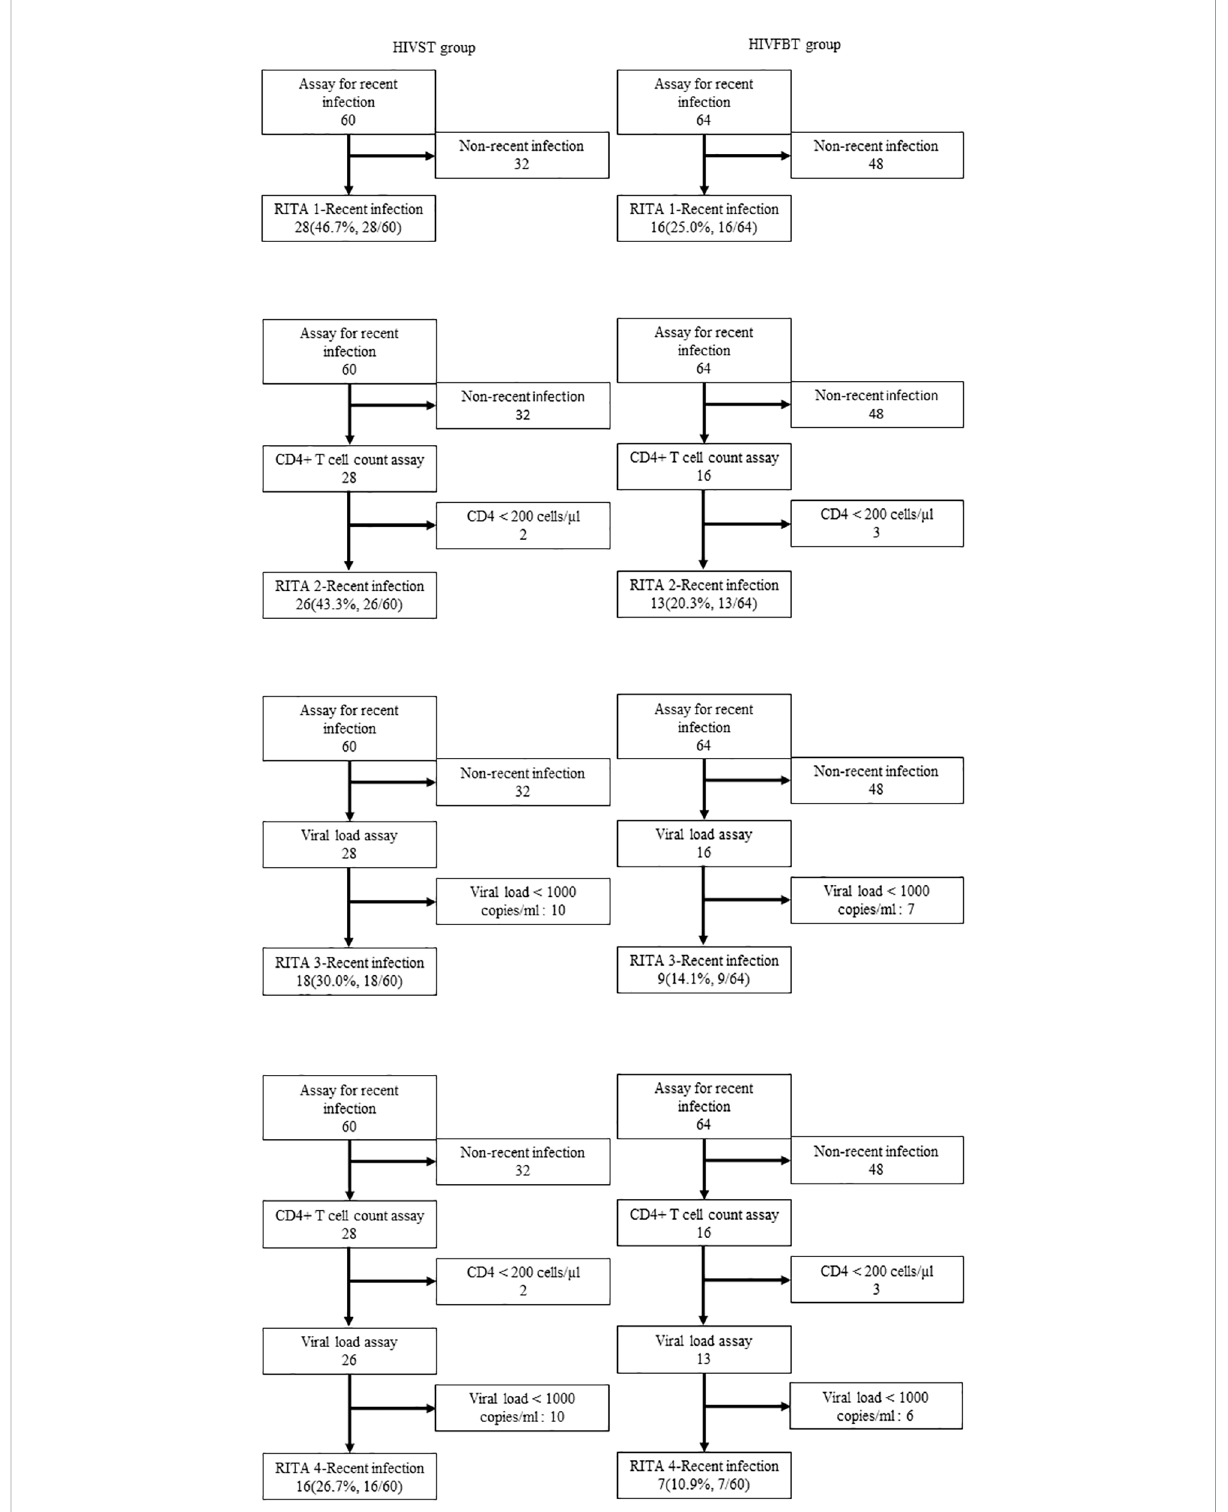
FIGURE 1 Flowchart of different recent infection testing algorithms (RITAs) among HIV infection status among men who have sex with men (MSM) diagnosed as HIV positive in Zhuhai, China. HIVST, HIV self-testing; HIVFBT, facility-based HIV testing; RITA 1, LAg-EIA only; RITA 2, LAg-EIA and CD4+ Tcell count; RITA 3, LAg-EIA and Viral Load; RITAs 4, LAg-EIA, CD4+ T cell count and Viral